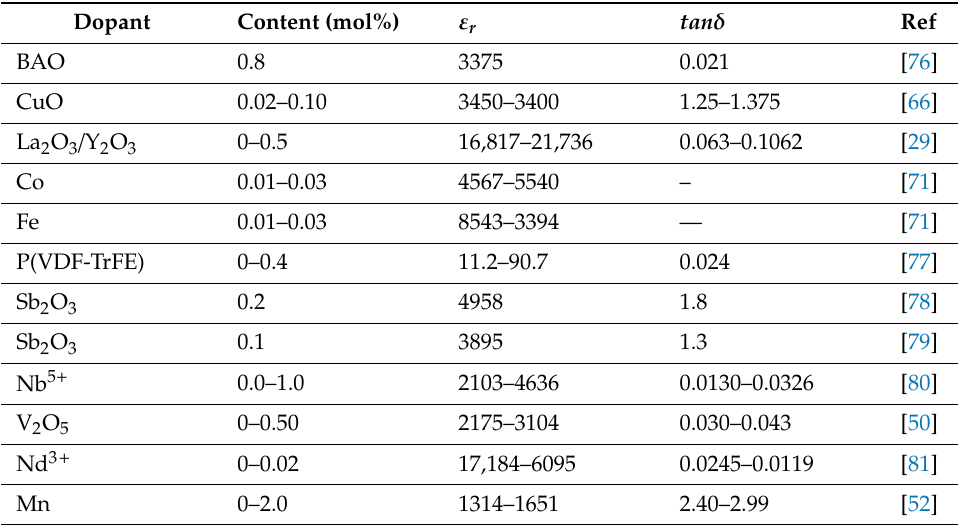
Table 1. The comparison of dielectric constant and dielectric loss for di ff erent